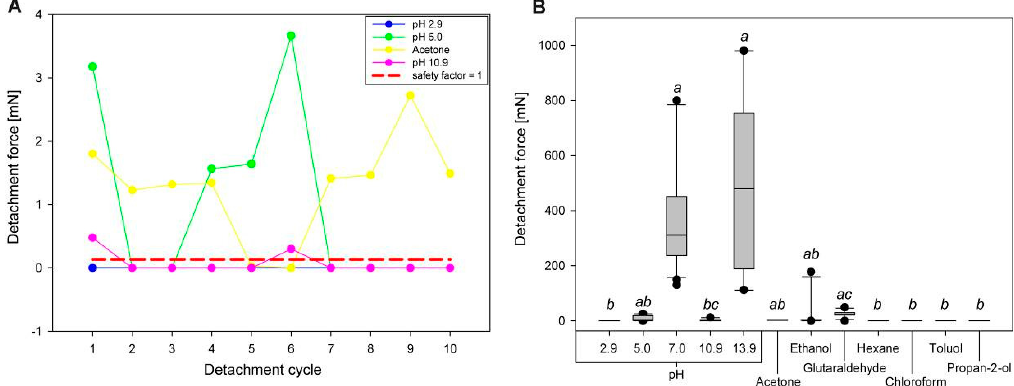
Figure 3. Solvent influence on attachment: ( A ) Line plots for sequential measurements of eggs exposed to different solvents, which revealed low detachment forces. The dashed red line represents a safety factor of 1, or a weight force of 0.136 mN (median weight of all eggs measured); ( B ) Boxplots of the initial detachment force (during the first cycle) of the eggs treated with all solvents used in sequential attachment experiments. The horizontal line represents the median, the upper and lower borders of the boxes represent 25 and 75 percentiles and the whiskers represent 10 and 90 percentiles. Groups with the same lowercase letter are statistically not different (Kruskal–Wallis ANOVA on ranks, Dunn’s post hoc test, p < 0.05).